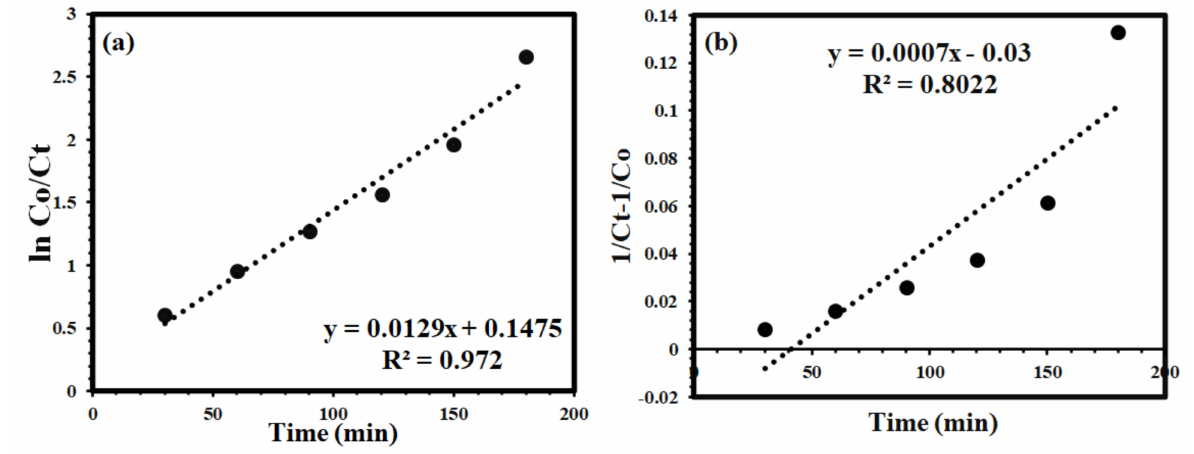
Figure 12. Kinetic models for the degradation of MO ( a ) 1st order, ( b ) 2nd order kinetic model using TNG-08